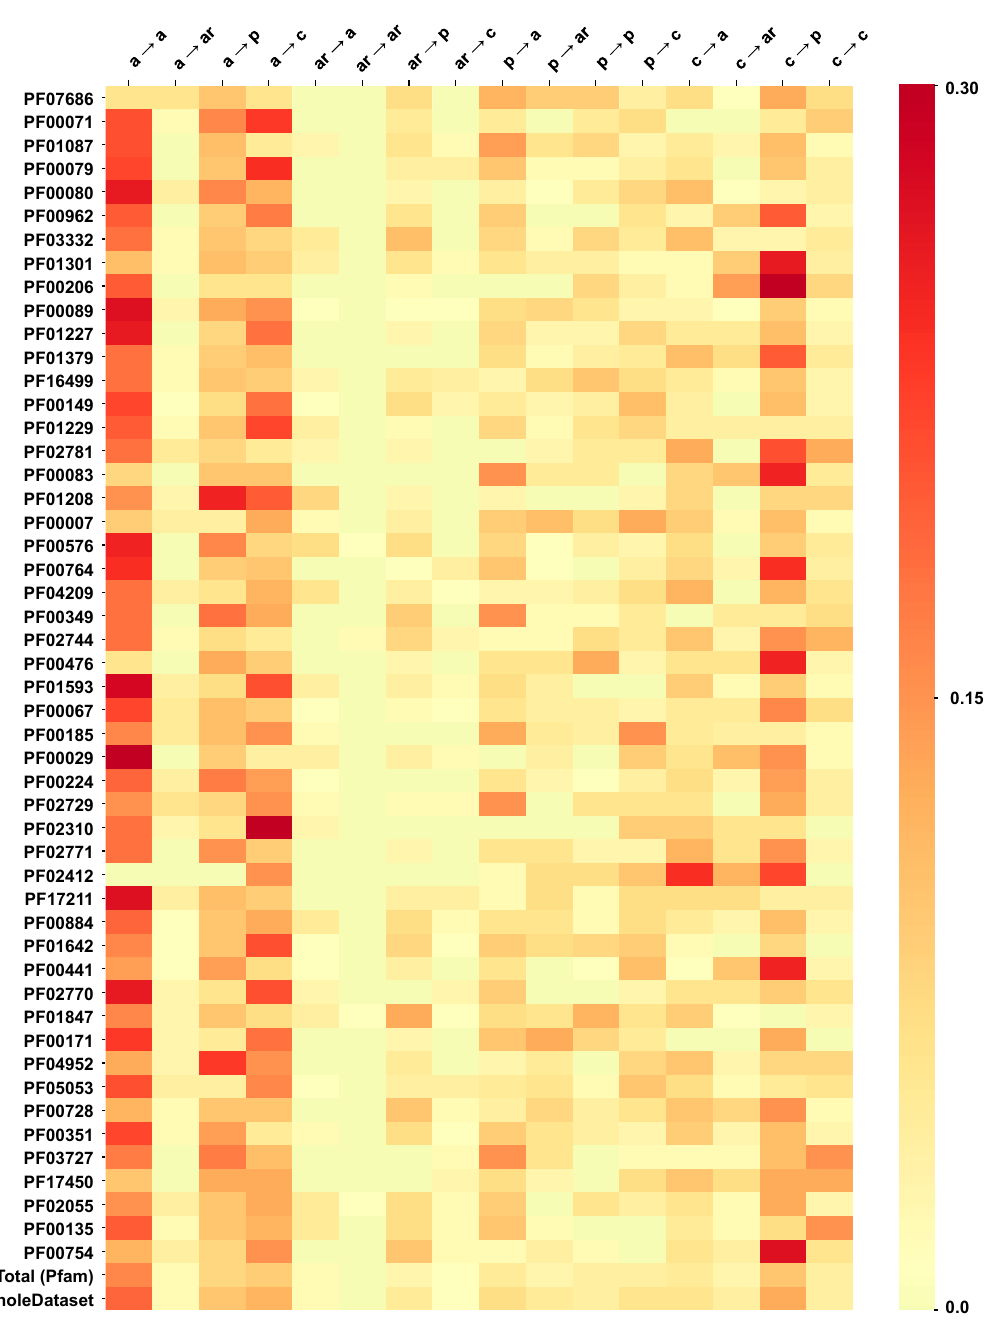
Figure 6. The heatmap shows the frequency of occurrence of each disease related variation type per Pfam domain. The color span from yellow (low frequency) to red (high frequency). Average and median Kullback–Leibler divergences between individual Pfam distributions and the background (WholeDataset) are 2.5 and 2.1 bits, respectively.